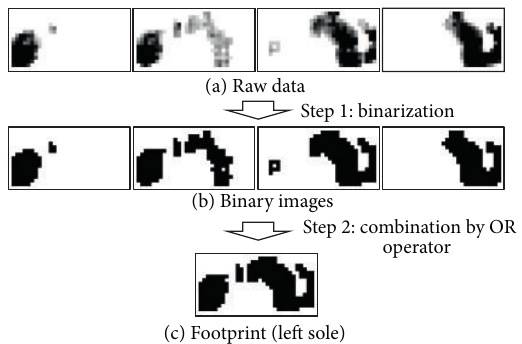
Figure 6: Procedure of the footprint